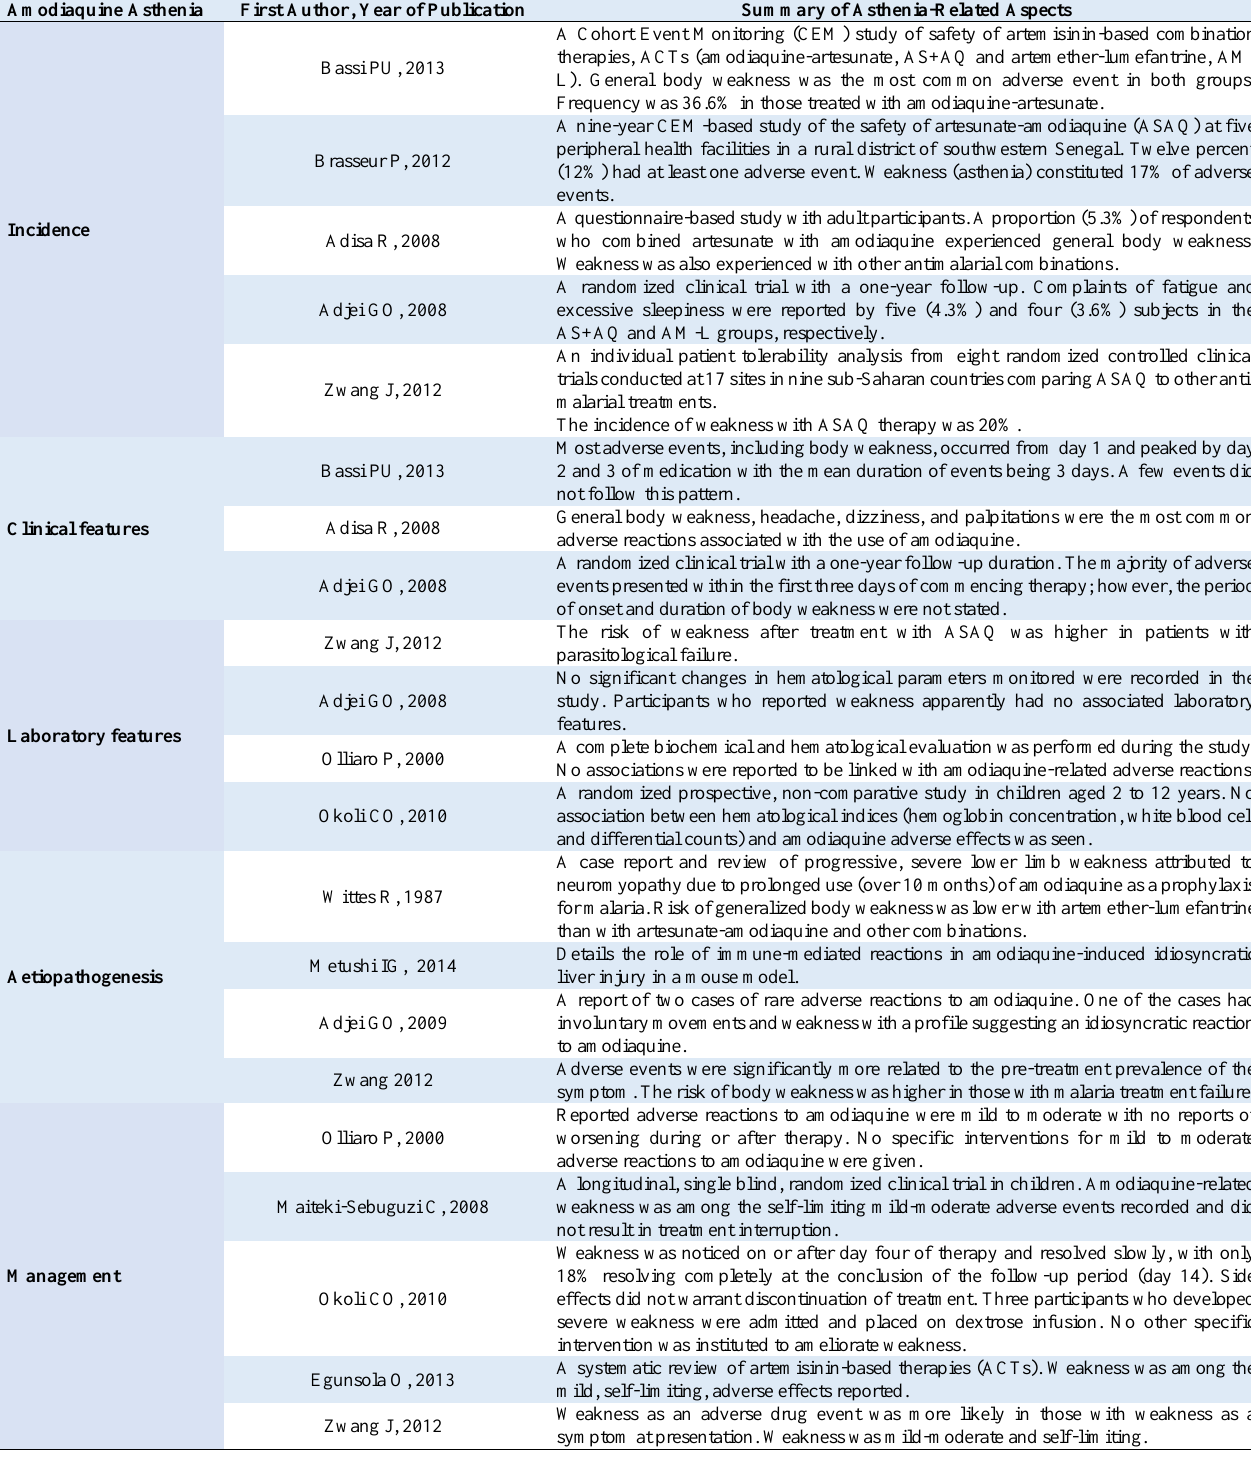
Table 1. Summary of literature review on amodiaquine-related asthenia Amodiaquine